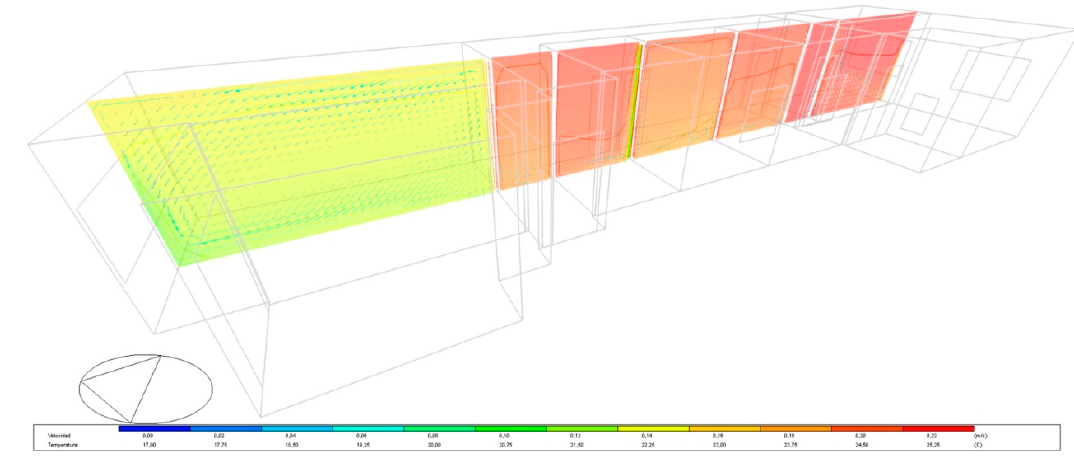
Figure 23. The radiant system using TCP panels; 1 August 2015, 4:00 p.m.